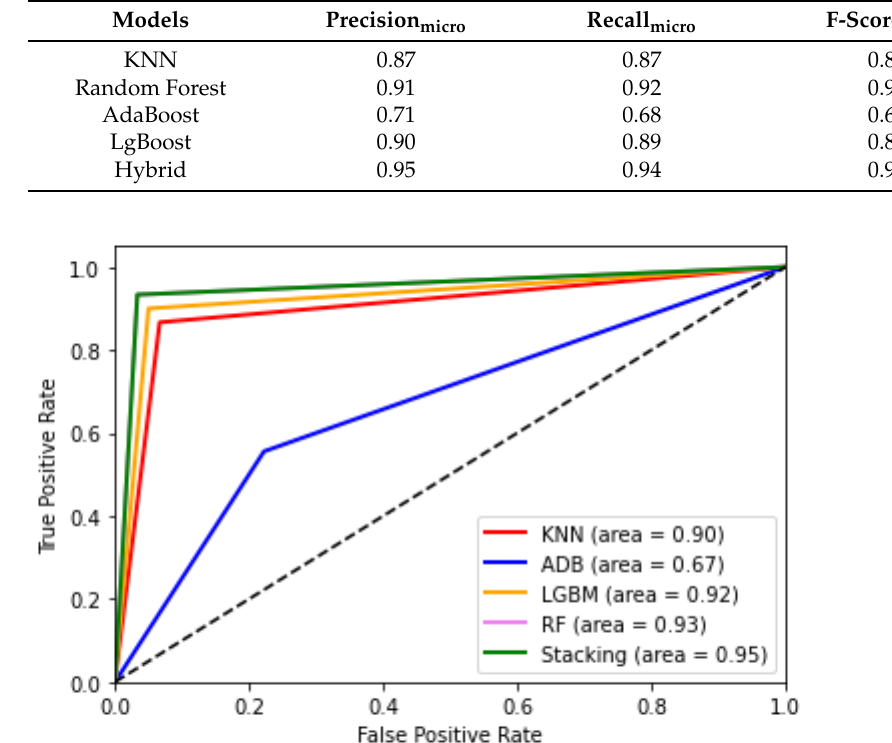
Figure 4. Comparison of different models using